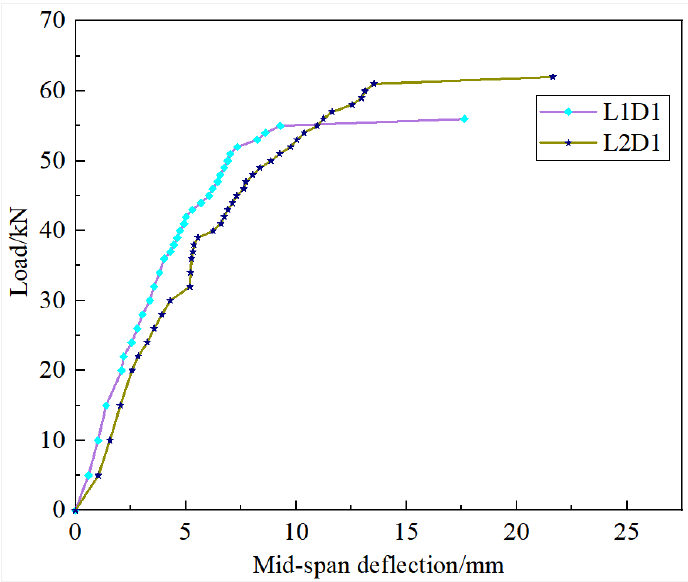
Figure 8. Load-deflection curve of L1D1, L2D1.